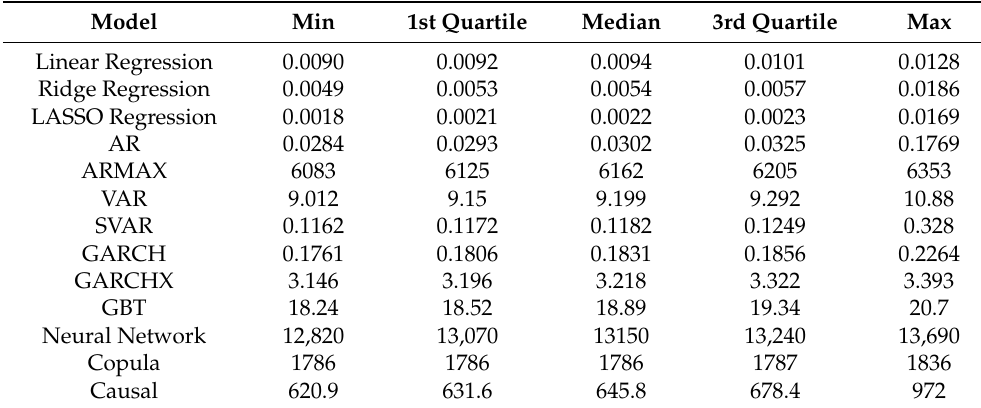
Table 3. Run time for each evaluated methodology in